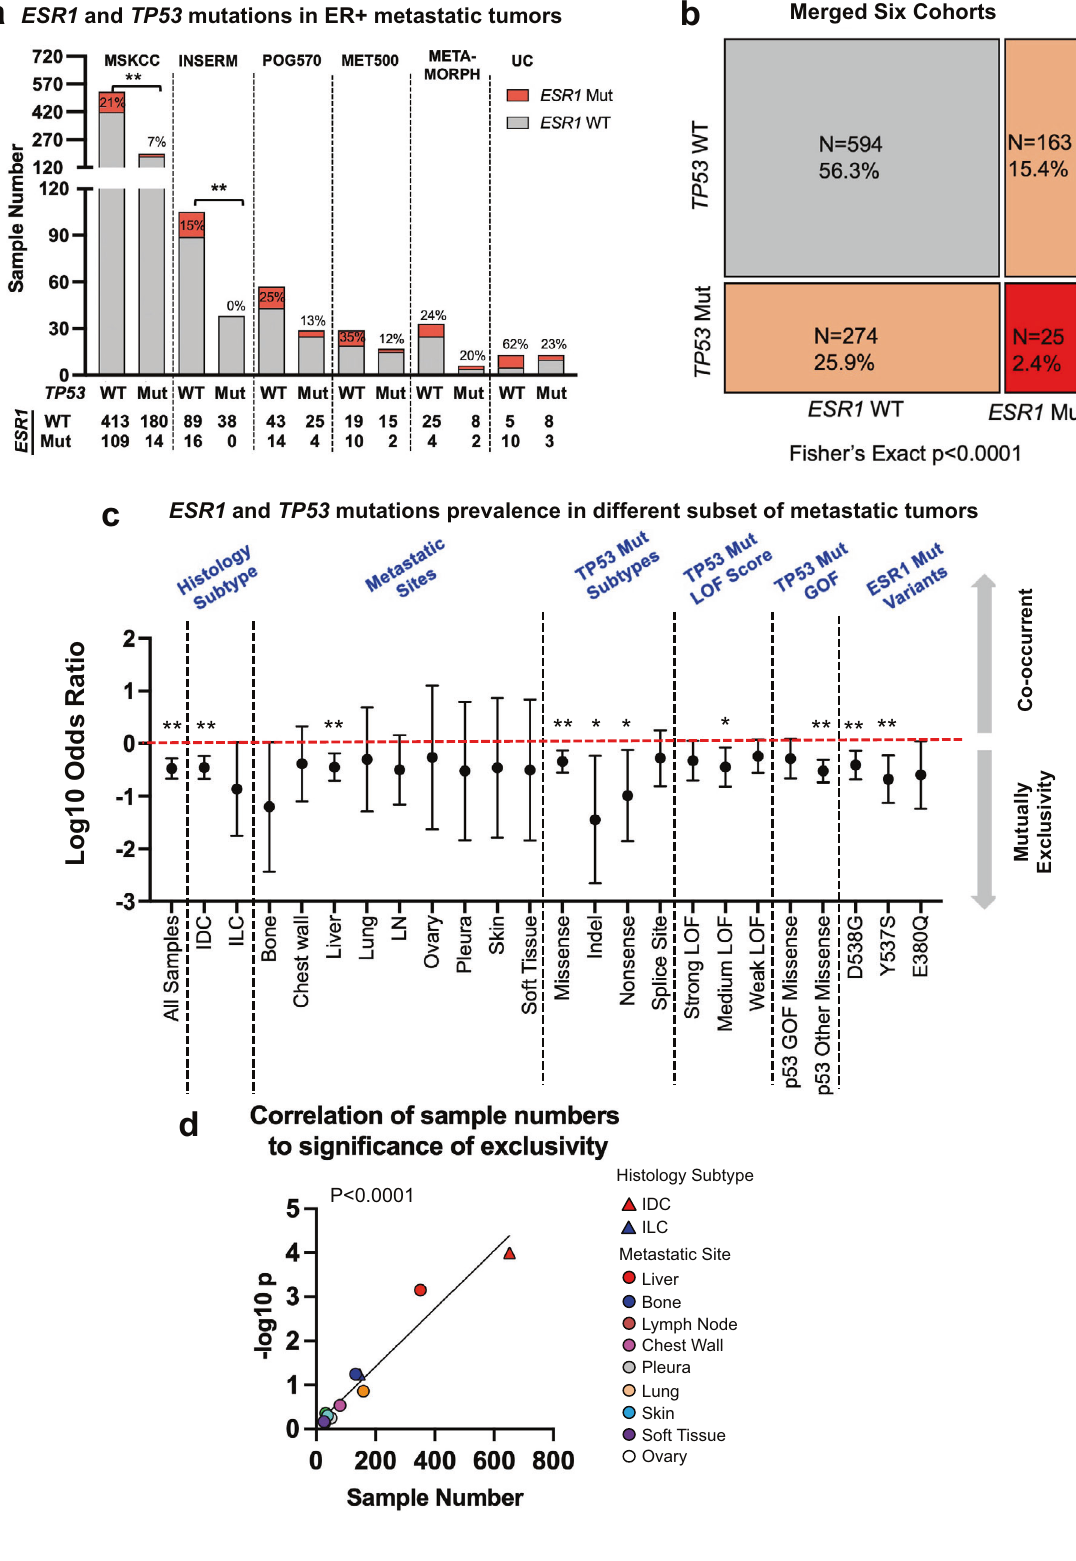
WT breast cancer cell lines ( n = 33) compared to TP53 mutant lines ( n = 9), whereas the Non-P53-ER Signature failed to differentiate the two subgroups, emphasizing the speci fi city of the de fi ned gene sets (Supplementary Fig. 3f and Supplementary Table